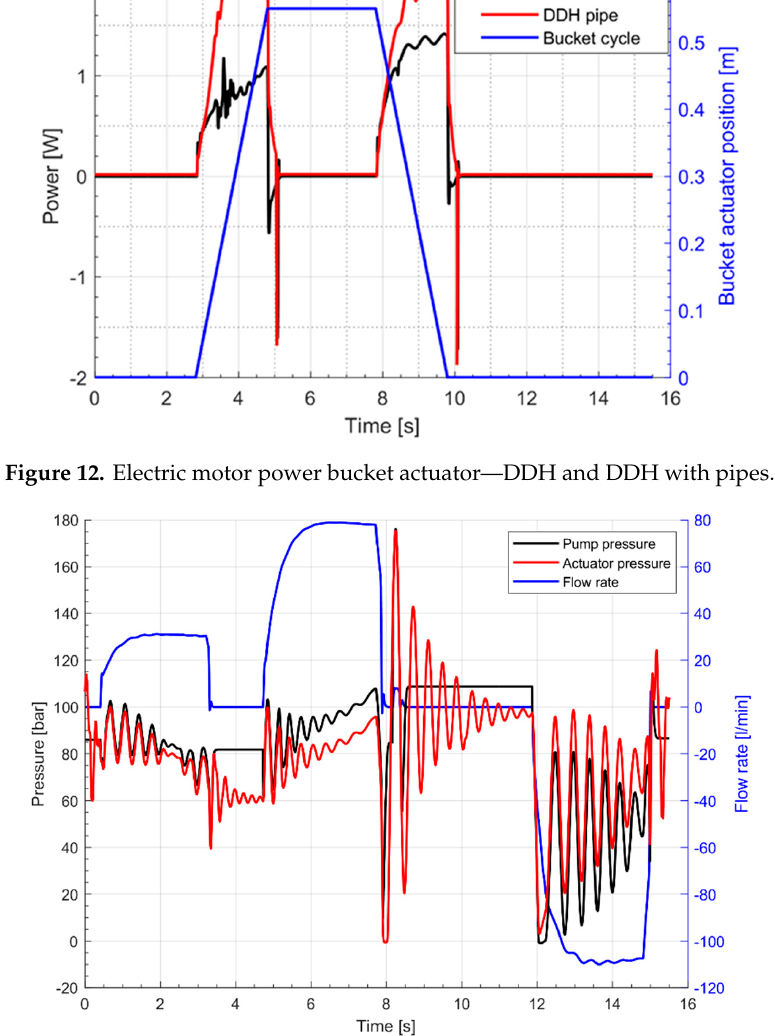
Figure 13. Boom actuator piston side, pressure and flow rate. DDH with pipes model.